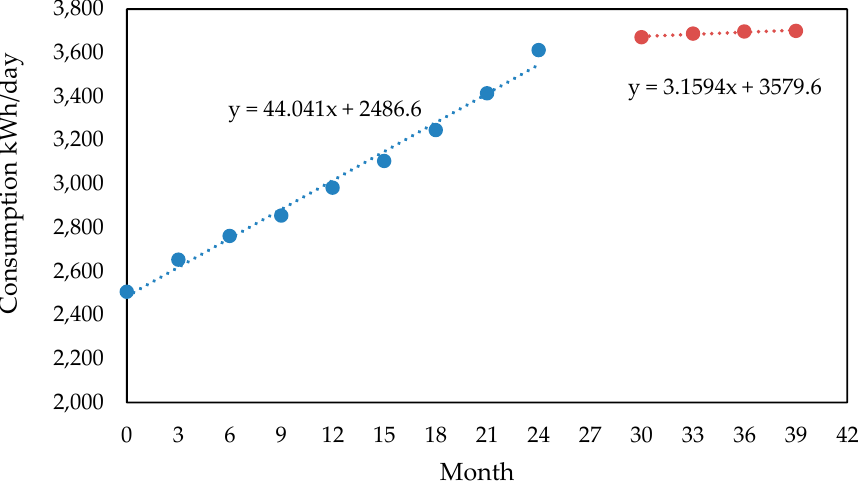
Figure 8. Total daily consumption rate of the Elevated Pumping System of Rio Branco, considering biofouling.